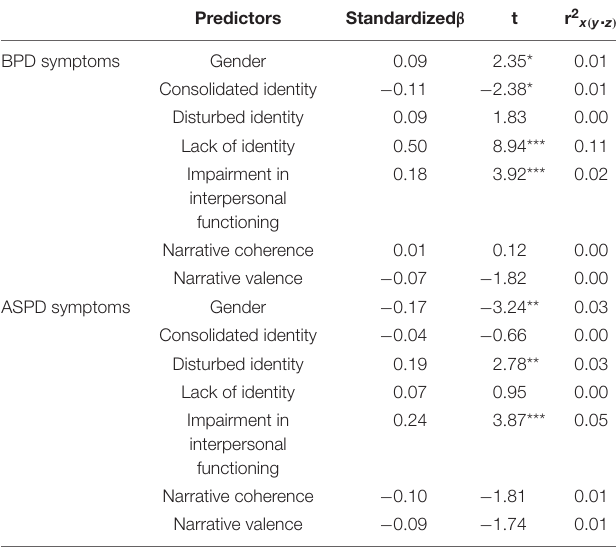
TABLE 4 | Hierarchical linear regression analysis predicting BPD and ASPD symptoms as a function of gender, identity functioning, impairment in interpersonal functioning, and narrative